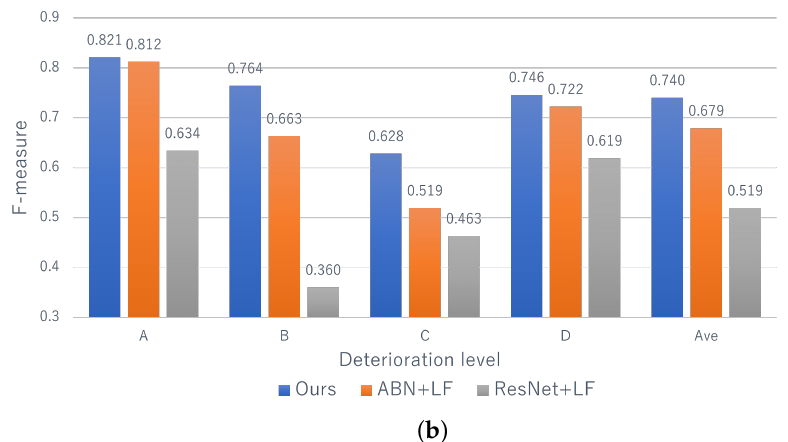
Figure 7. The estimation results for each record. LF indicates the late fusion. ( a ) Efflorescence and ( b )